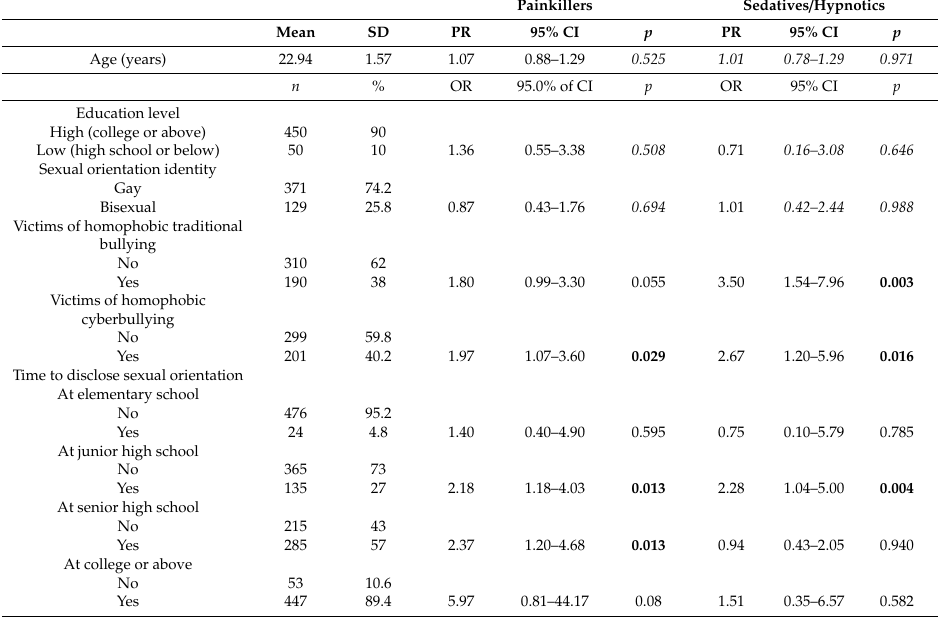
Table 2. Associations of demographic factors, sexual orientation and victimization of homophobic bullying with painkillers and sedatives / hypnotics use examined by univariate logistic regression ( n =